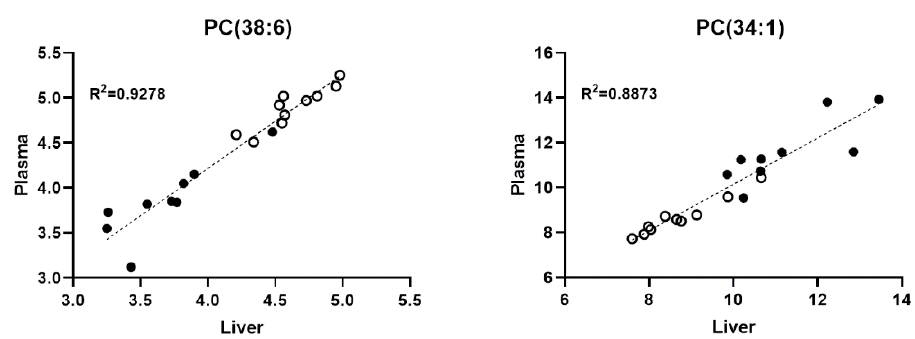
Figure 4. Correlation between the liver and the plasma relative lipid concentrations for PC (38:6) and PC (34:1). Black: WT samples, open: CypD-/- samples. Mol% of polar lipid values were correlated using the Pearson correlation.